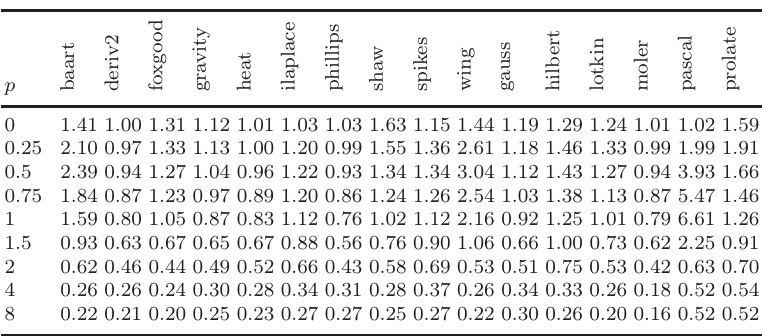
Table 7. Means of error ratios for v maxDe by problems.